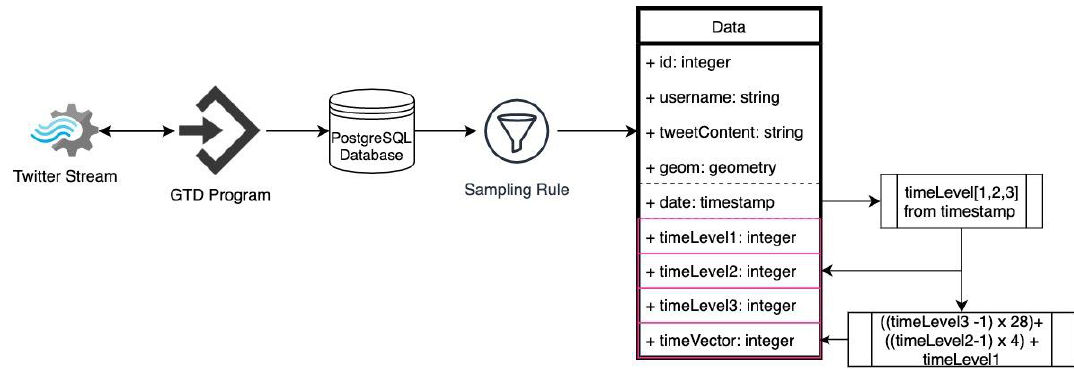
Figure 2. Data downloading and tidying flow.